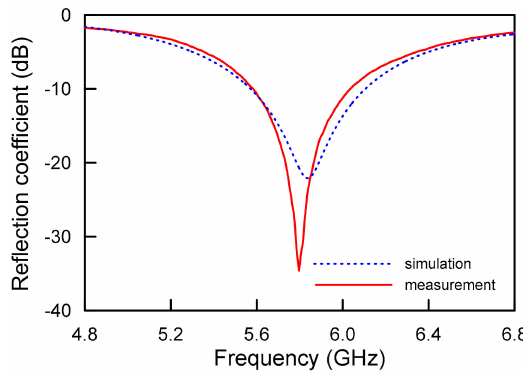
Figure 5. Coe ffi cients of the proposed antenna.